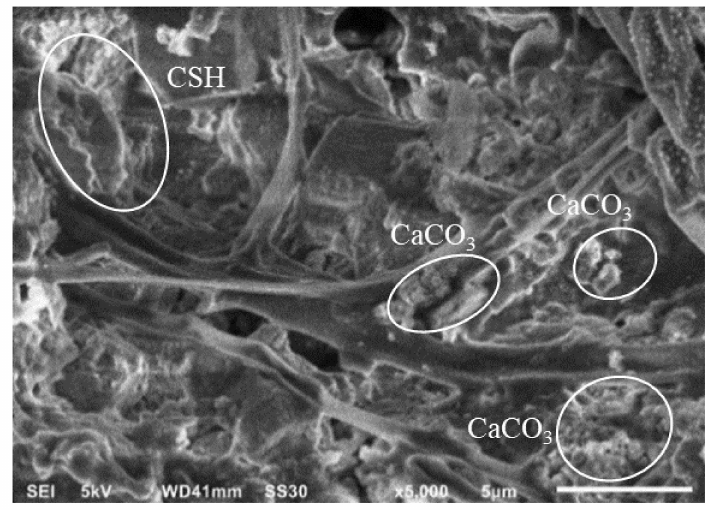
Figure 14. The topography of the 3% OPS-activated charcoal and 1% EFB hydrochar mortars, with a magnification of 5000 ×